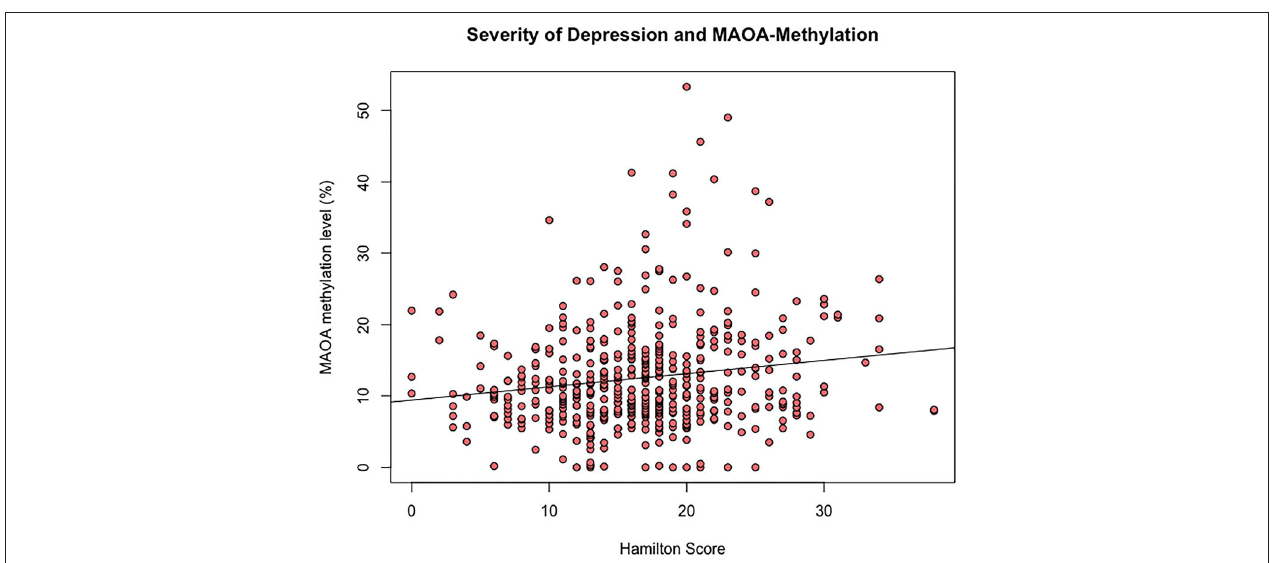
FIGURE 3 | Scatterplot of Hamilton Depression Score and MAOA gene promoter region exon I methylation (%) of female affective disorder patients ( τ = 0.12, p < 0.001, n = 535).